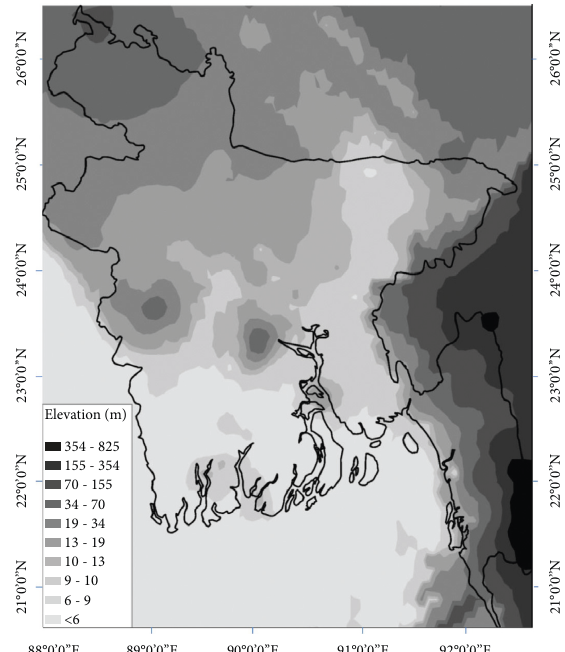
Figure 1: Elevation map of Bangladesh.